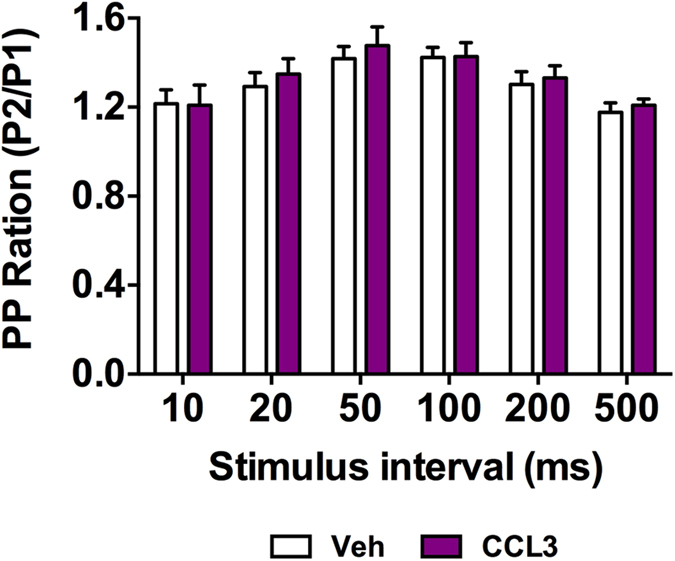
CCL3 does not affect paired-pulse facilitation.Paired-pulse ratio remains unchanged in the presence of CCL3 at the different stimulus interval studied (10, 20, 50, 100, 200 and 500 ms, n = 5).